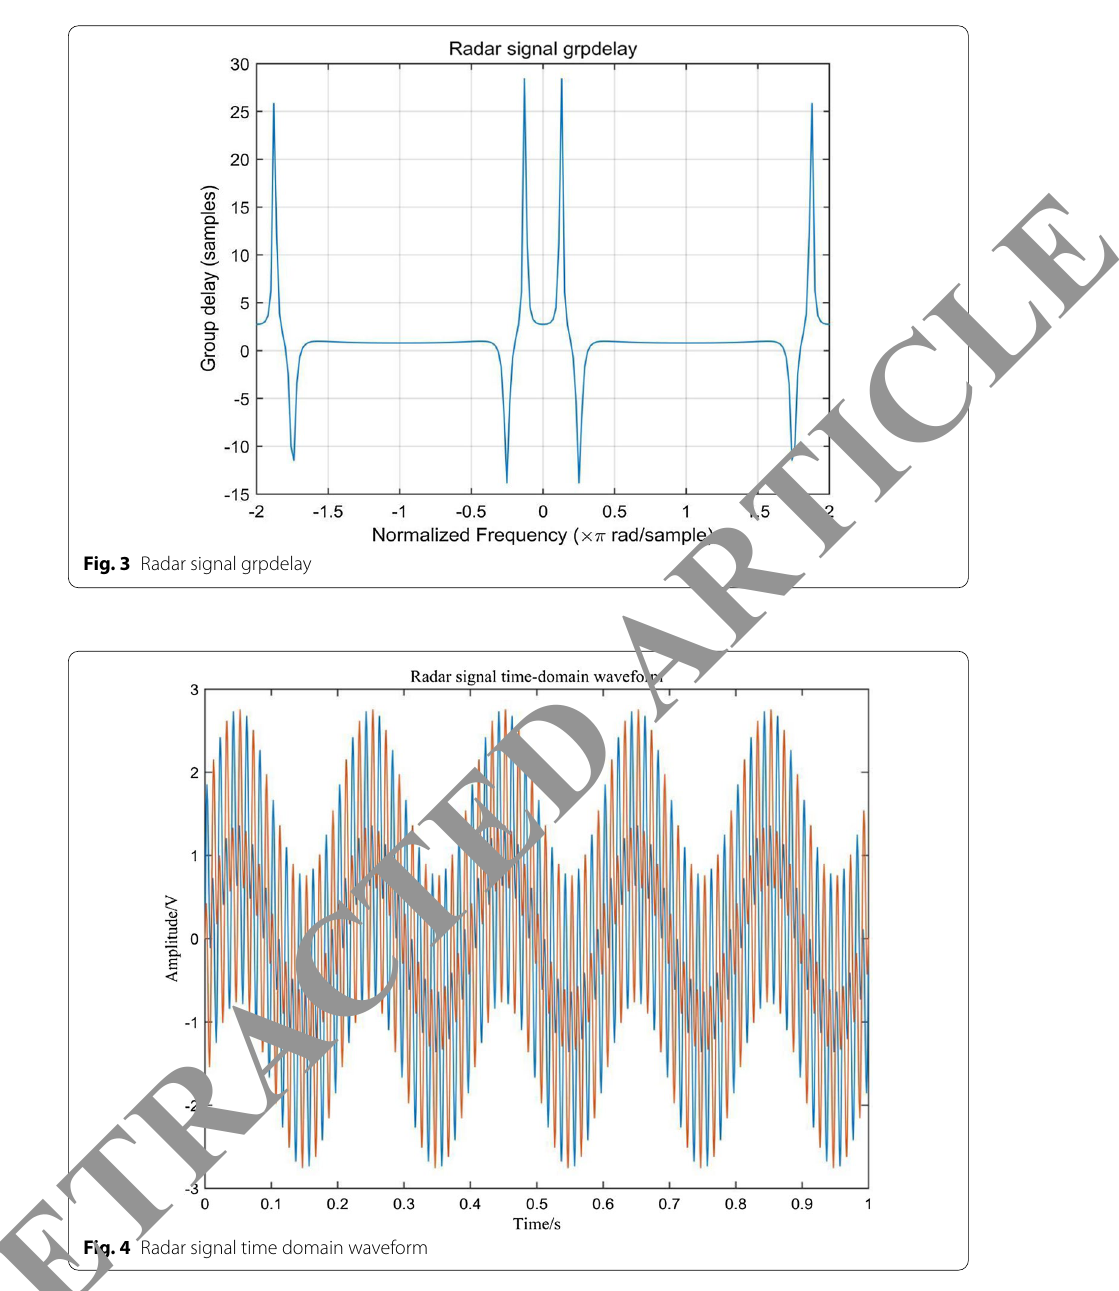
Fig. 4 Radar signal time domain